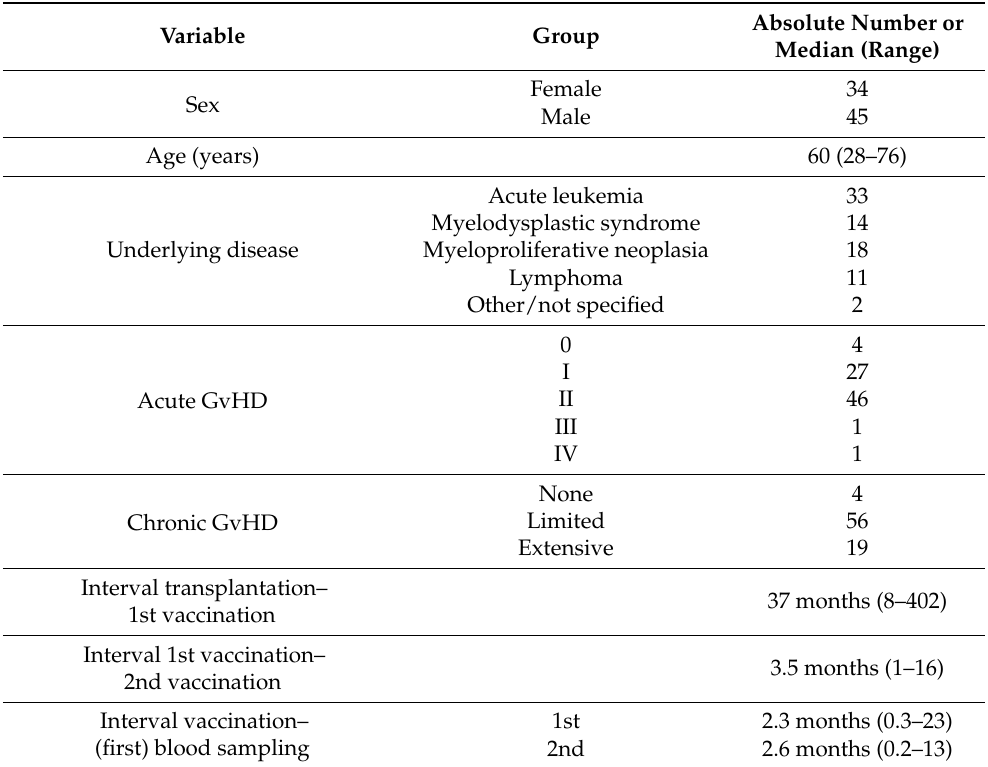
Table 1. Characteristics of 79 hematopoietic stem cell transplant recipients tested prior to and post vaccination with